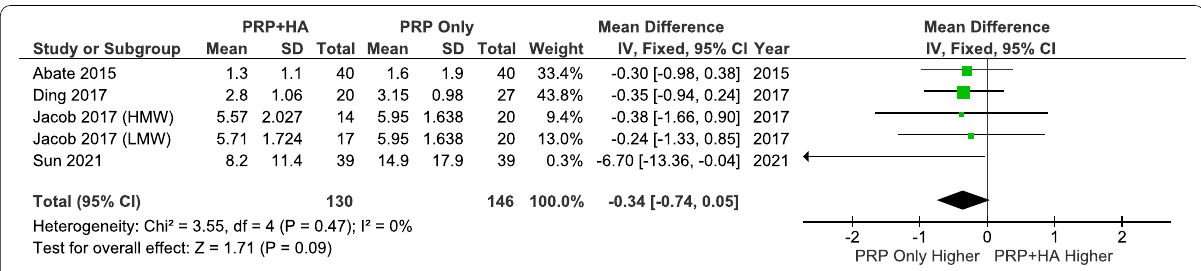
HA and PRP at 6 months after treatment +